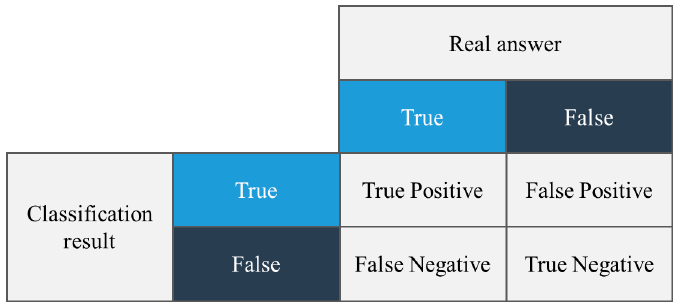
Figure 7. The terminology used to calculate the accuracy.